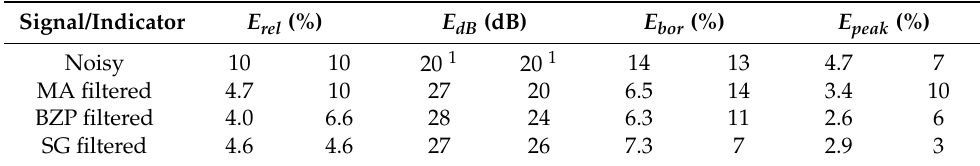
Figure 4. Point by point error as difference between each processed signal and the analytical refer- ence. Table 4. Performance indicators for low pass filtering of noisy 2 and 5 Hz time signals.